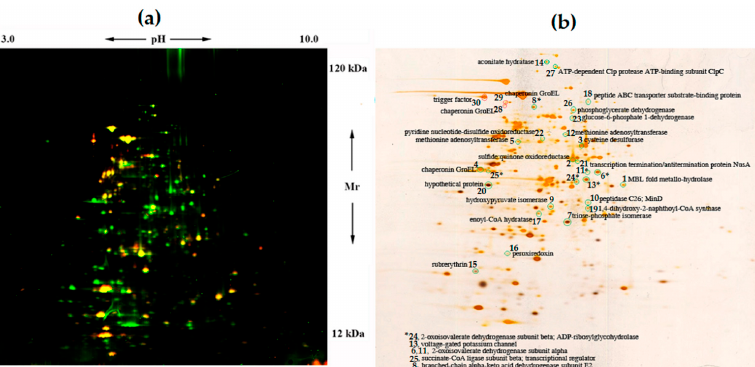
Figure 1. Two-dimensional (2D) DIGE analysis of Sb. thermotolerans cells grown in the presence of the arsenopyrite concentrate (Cy3 dye, green) and in the control medium (Cy5 dye, red) ( a ) and a corresponding silver-stained gel ( b ). Arrows ( a ) indicate pH (3–10) and Mr (12–120 kDa) ranges. Circled spots ( b ) correspond to proteins ≥ 2-fold up- (green circles) or downregulated (red circles) in response to the concentrate (spot numbers refer to Table 3) and identified by MALDI (Matrix-Assisted Laser Desorption/Ionization) mass spectrometry.